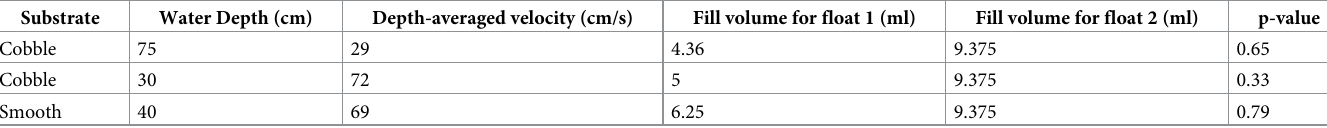
Table 4. T-test results for paired sets of rising body measurements.